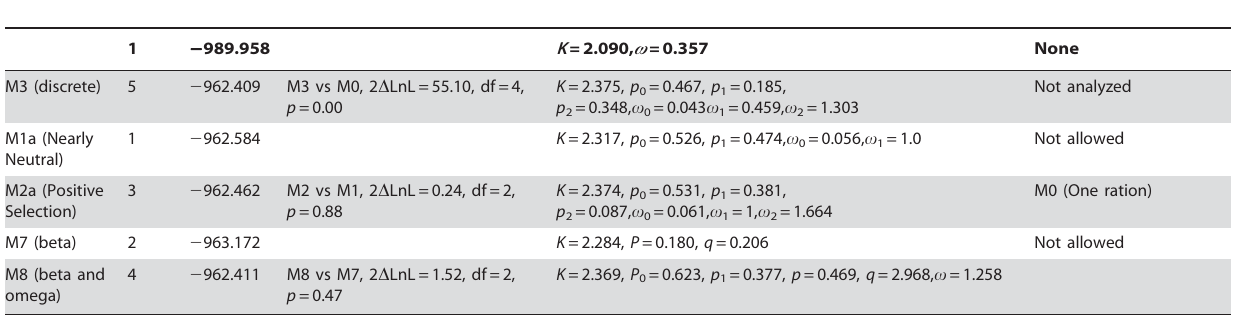
Table 2. Evidence of positive Darwinian selection from site-specific model analyses for the HAMP gene of